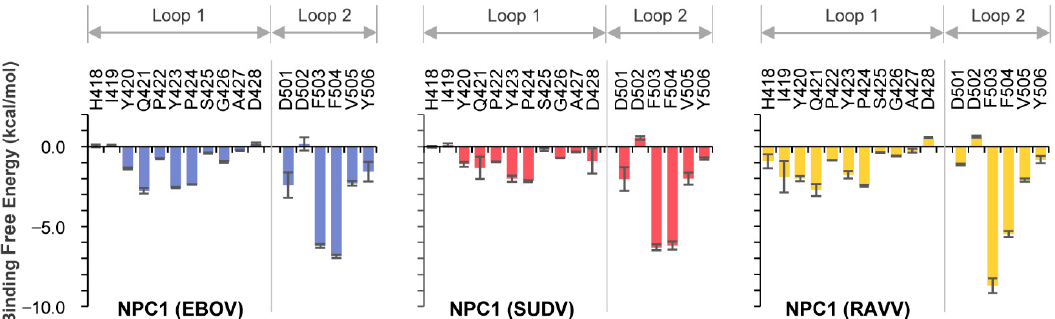
Figure 2. Per-residue contribution of NPC1 loops in the GPcl–NPC1 complexes to the binding free energy. Per-residue contribution to the binding free energies of loop 1 and loop 2 in the EBOV, SUDV and RAVV GPcl–NPC1 complexes were calculated using the MM/GBSA free energy decomposition method. Each MD simulation was conducted three times, and average and standard errors (SE) are shown. Table 1. Estimated average total binding free energies between NPC1 loop and GPcl of EBOV,